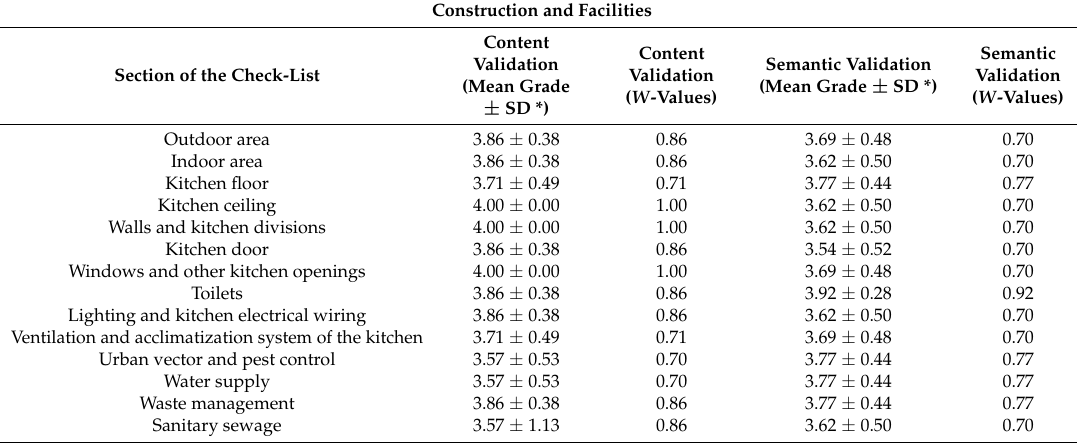
Table 1. Experts’ evaluation of the instrument, mean grades of the items, and the Kendall coefficient ( W ) of the section of the check-list. Bras í lia, DF,